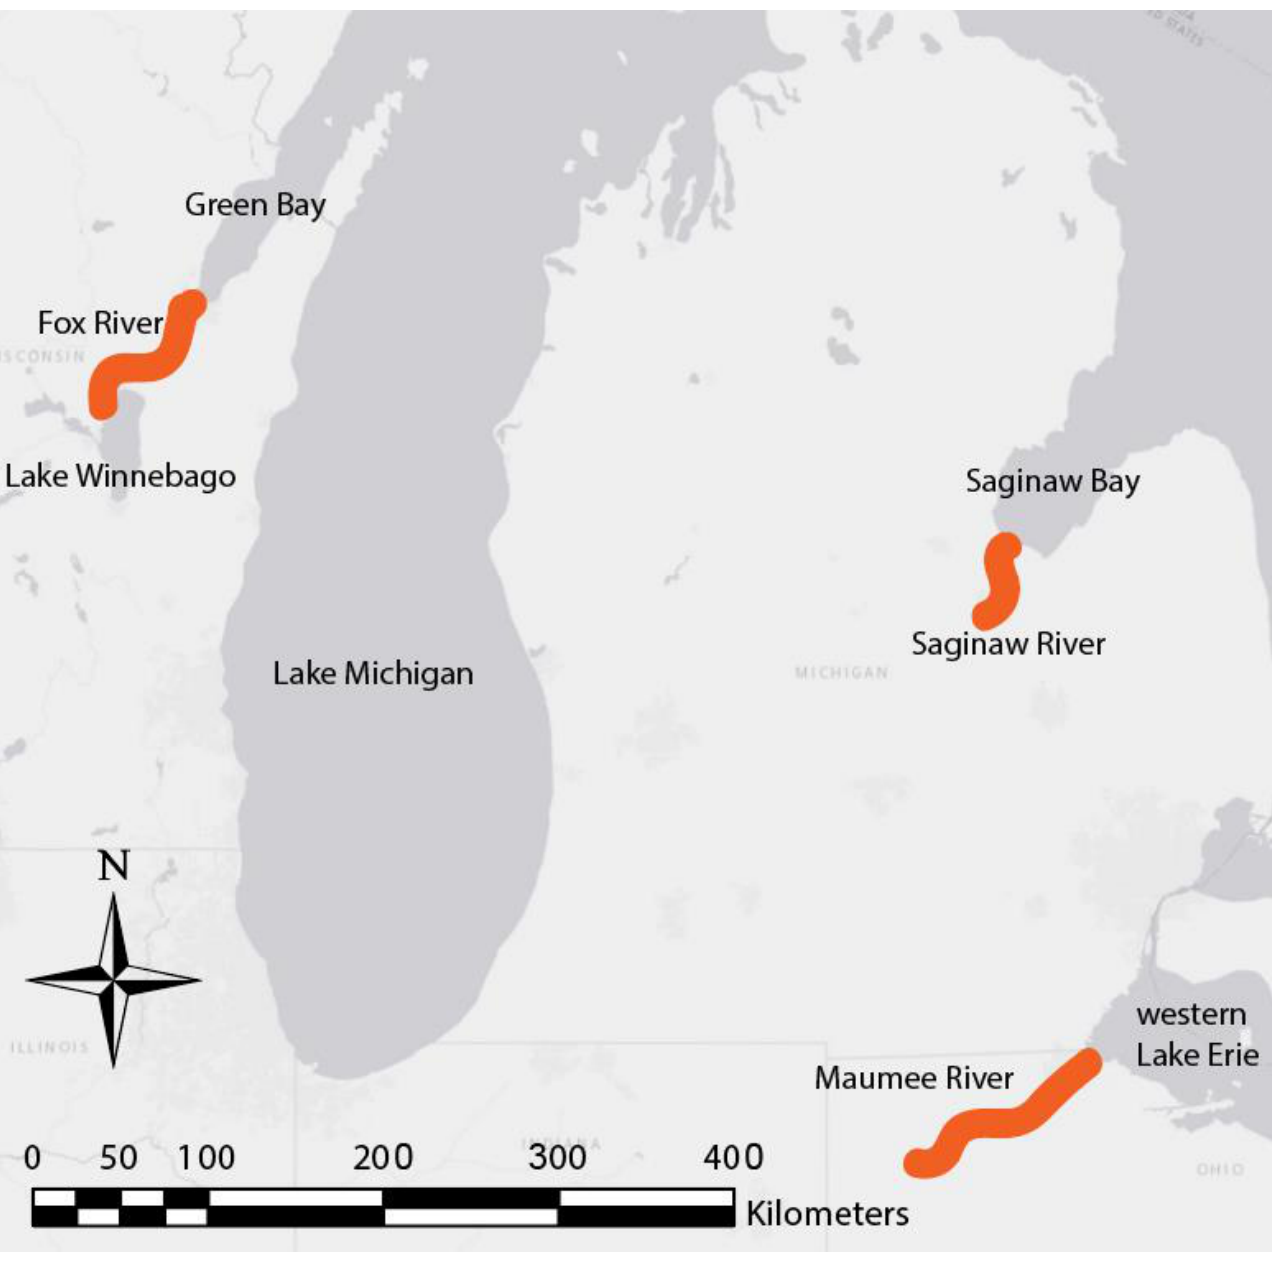
Figure 1. Line map of the Study area showing locations of Green Bay within Lake Michigan, Saginaw Bay in Lake Huron, and the western Lake Erie Basin. The rivers of interest are highlighted.